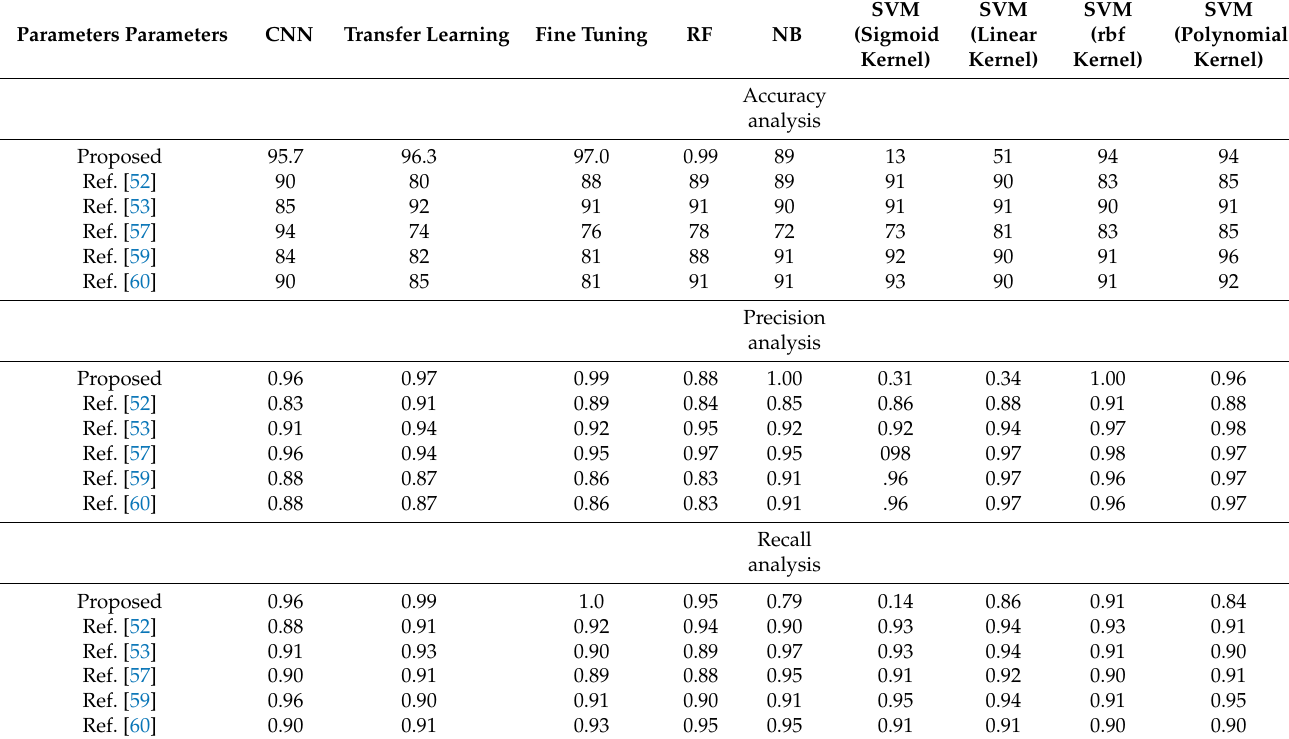
Table 4. Performance comparison of the proposed work with the existing methods.